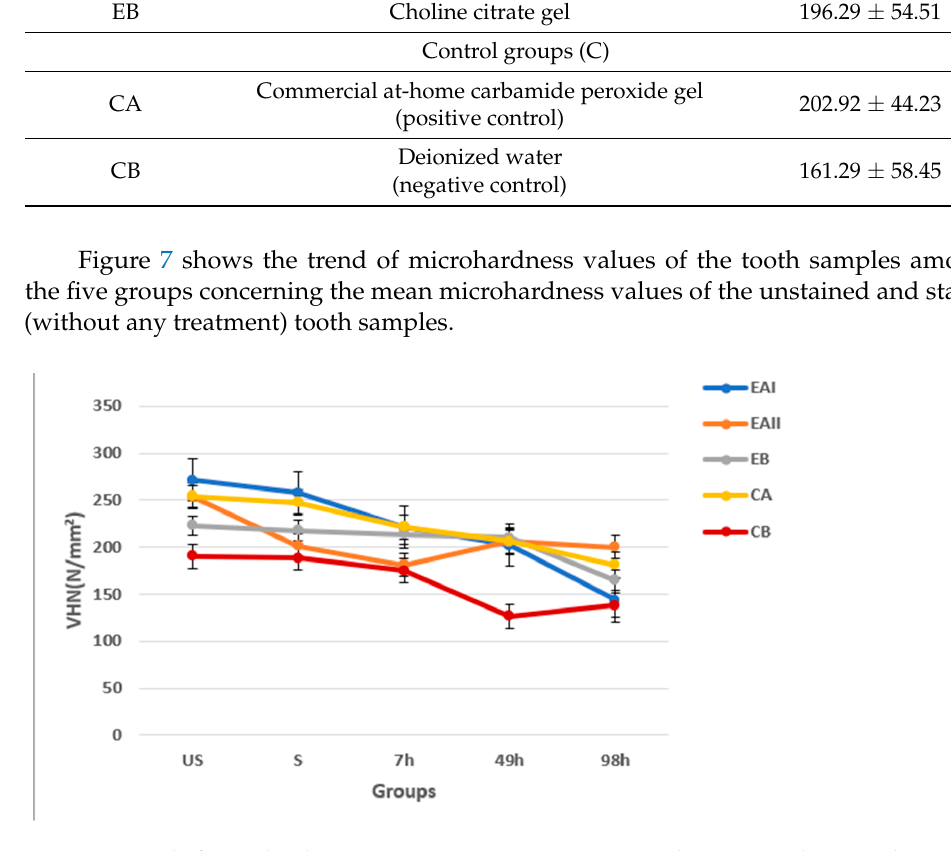
Table 4. Mean microhardness values of the tooth samples after treatment .